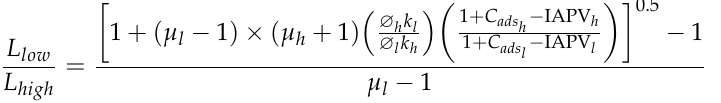
Table 3. Gelant placement cases